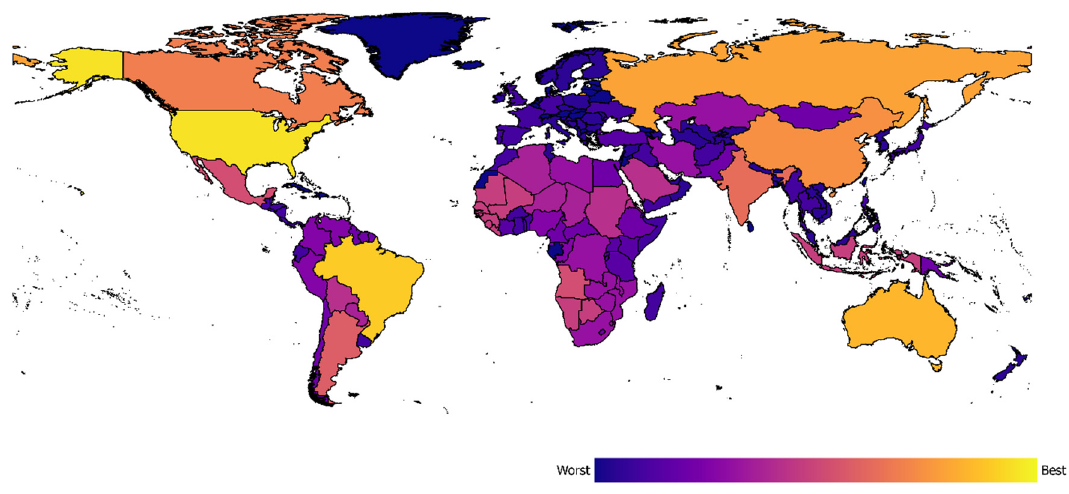
Figure 3. Global view on the availability